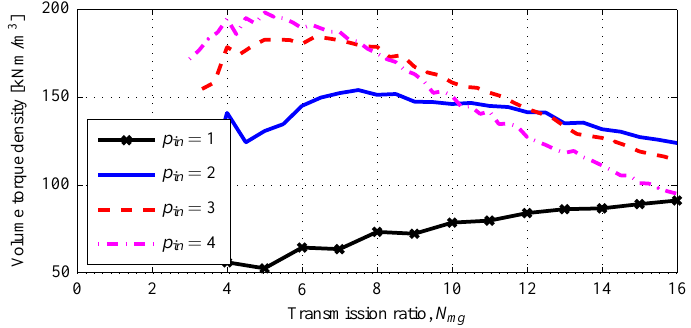
Figure 18. Optimized volume torque density characteristic of the magnetic gear as a function of its transmission